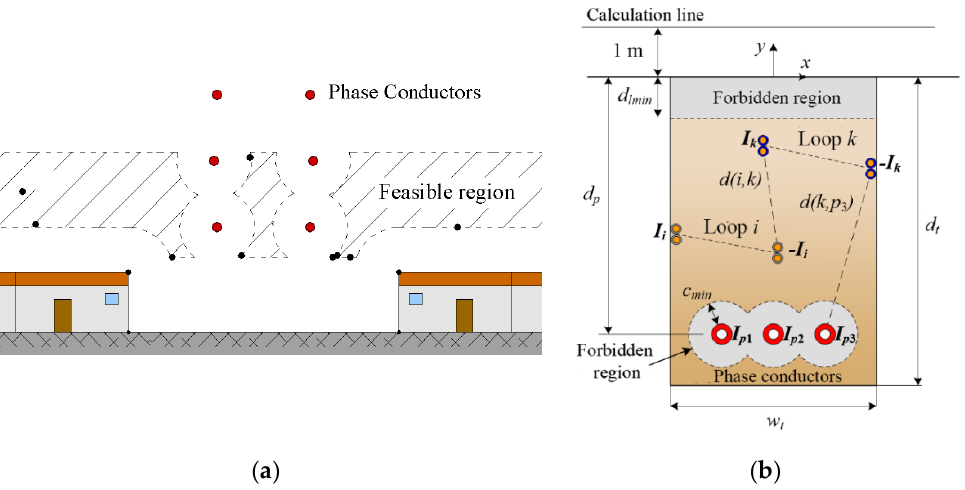
Figure 8. Some parameters and constraints involved in the design of ( a ) passive loops in OHL and ( b ) enchained loops for an UPC.